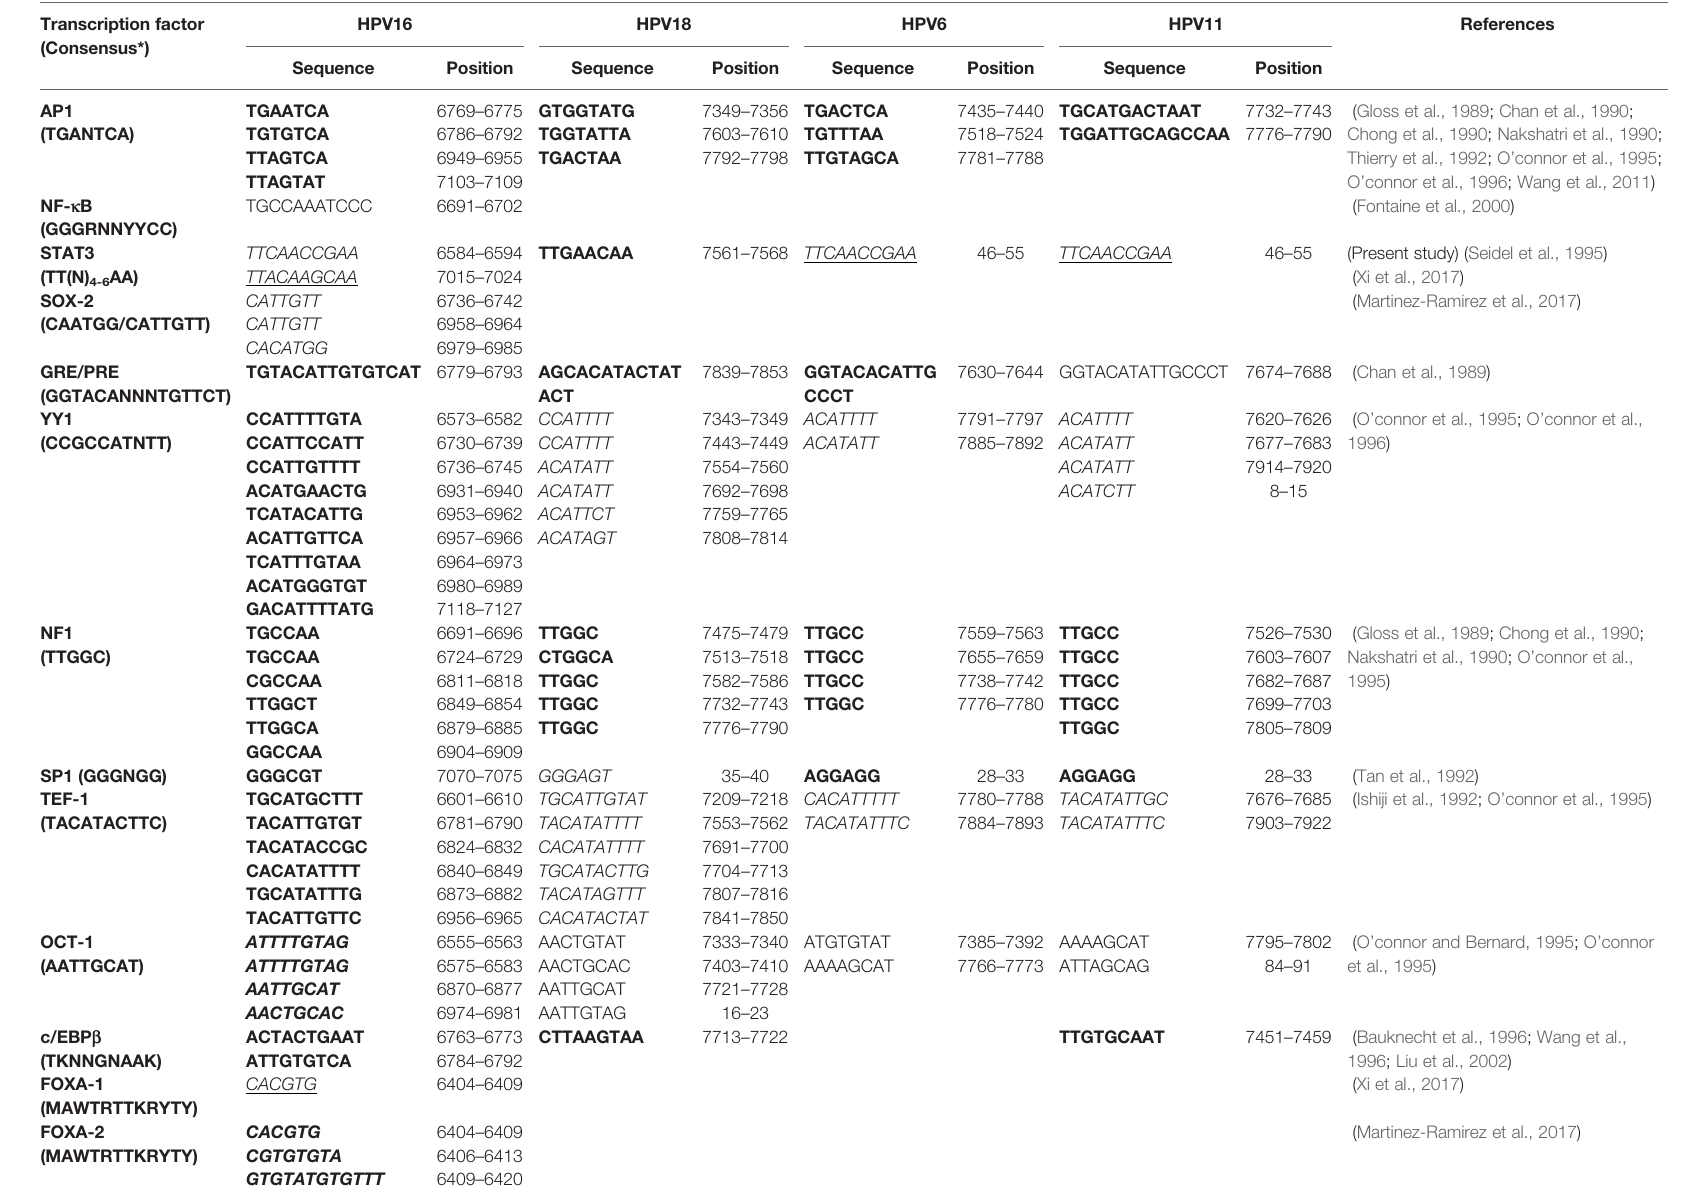
TABLE 1 | Transcription factor binding site on LCR of HPV16 (831 bp), HPV18 (835), HPV6 (811 bp), and HPV11 (755